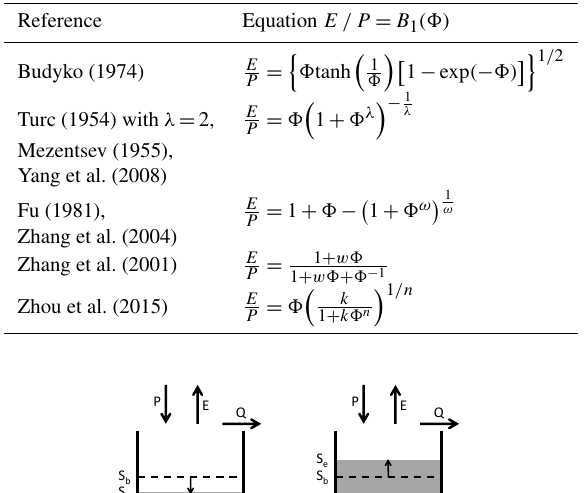
Table 1. Different expressions for the Budyko curves under steady- state conditions.